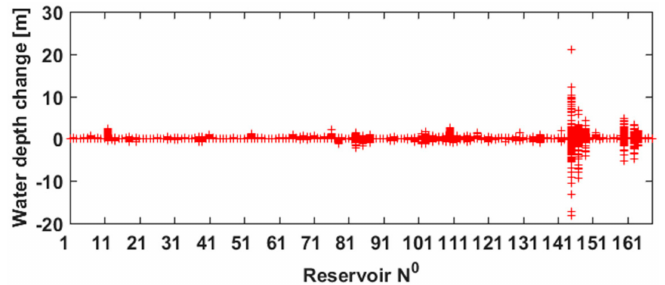
Figure 11. Daily water depth fluctuations of the studied